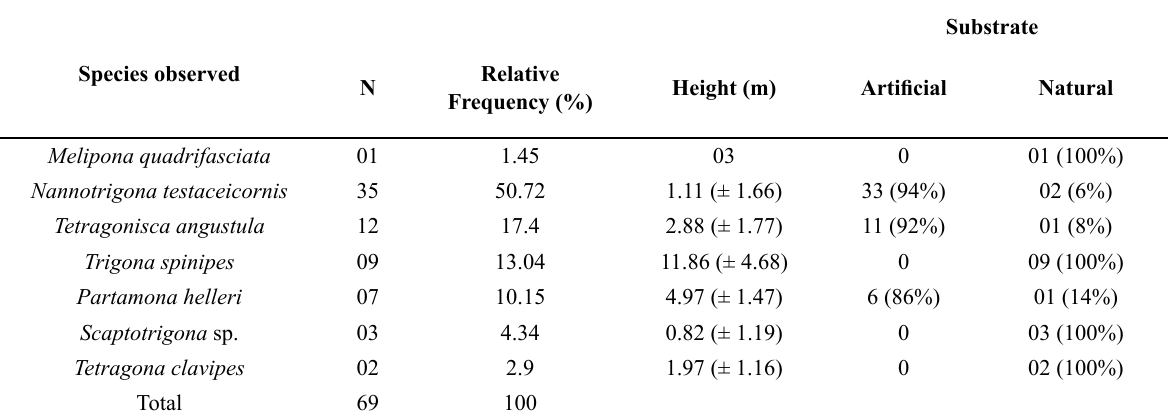
Table 1: Number of nests (N), relative frequency, height (m) from the ground to the nest entrance, and substrates used for nesting by stingless bees in the campus of the Federal University of Juiz de Fora, southeastern